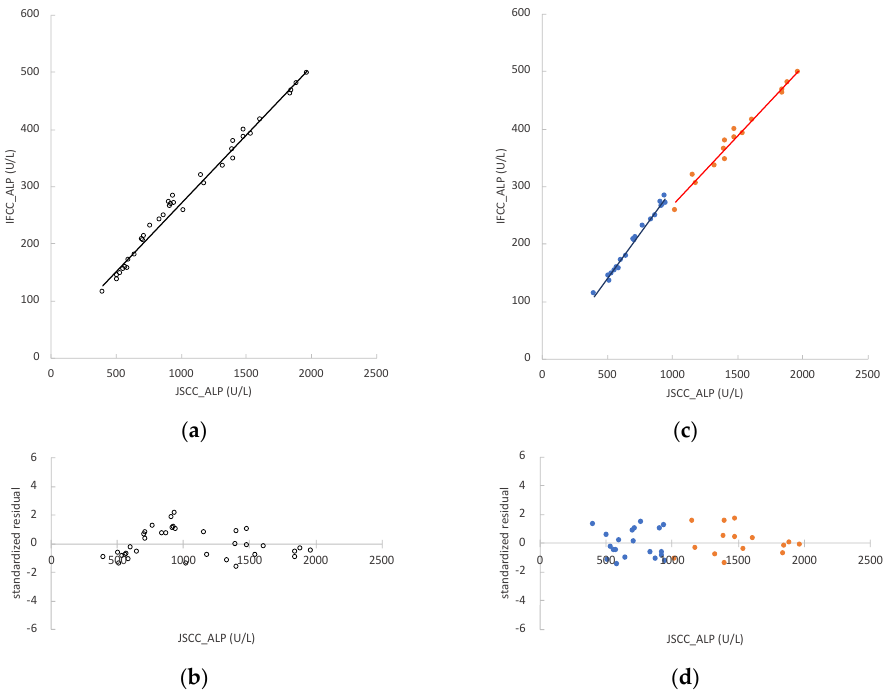
Figure 4. Correlation between alkaline phosphatase (ALP) activities measured by the Japan Society of Clinical Chemistry (JSCC) and International Federation of Clinical Chemistry and Laboratory Medicine (IFCC) methods in rat serum samples. The x-axes represent the values obtained by the JSCC method, and the y-axes represent those obtained by the IFCC method: ( a ) regression analysis comparing the JSCC and IFCC values of all samples ( n = 35), represented by the formula y = 0.241x + 30.666; ( b ) standardized residual plots obtained using the regression equation of all samples ( n = 35); ( c ) regression analysis comparing the JSCC and IFCC values of fed rats ( n = 15, orange dots) and fasted rats ( n = 20, blue dots), represented by the formulas y = 0.243x + 22.355 and y = 0.314x − 17.626, respectively; ( d ) standardized residual plots obtained using the regression equations of fed rats ( n = 15, orange dots) and fasted rats ( n = 20, blue dots).